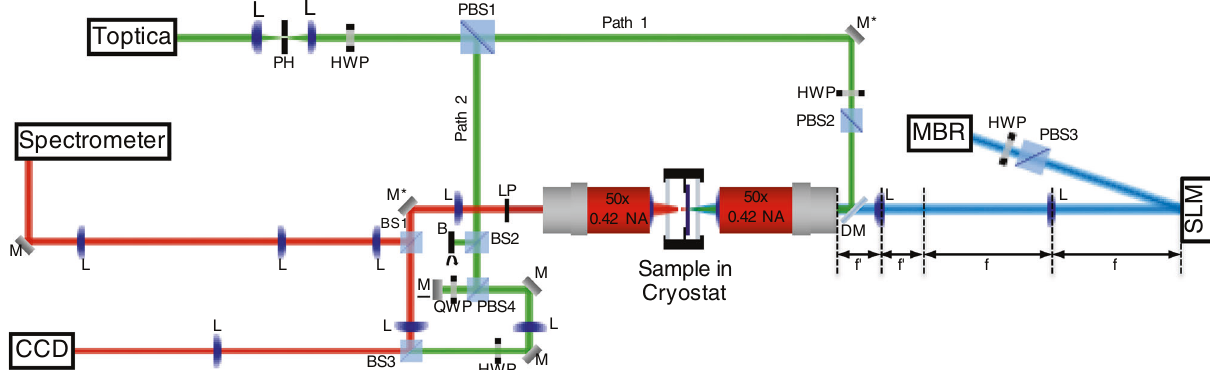
Fig. 6 Experimental set-up. Equipment: mirrors (M, M* (periscope), M (mounted on translation stage), DM (dichroic mirror)); lenses (L); polarising beam splitter (PBS); non-polarising beam splitter (NPBS); half-wave plate (HWP); quarter-wave plate (QWP); long-pass fi lter (LP); and beam block (B). Simultaneously, real-space PL is detected onto the uncoupled CCD and 2D Fourier space is projected onto the spectrometer allowing us to view either the 2D Fourier space or the energy-resolved dispersion by using the grating. The external seed laser is brought to be resonant with the PL by going on the grating and detecting the PL from BS1 and the laser by removing block (B) in front of BS2 and tuning the external laser. For the homodyne interferometry, the external seed laser is split before the sample, along path 1, a small amount seeds one of the condensates, while along path 2, the remainder is interfered with the PL on BS3. The path of the external seed laser is shown in green, the PL is shown in red and the excitation laser is shown in down path 1, directed onto the sample using a dichroic mirror, which passes the excitation laser but re fl ects the PL wavelength; and the rest down path 2 where the laser is interfered with the PL on BS3 for homodyne interferometry. The remainder of the excitation laser is fi ltered with a long pass fi lter and the paths are brought to zero time delay by controlling mirror M, which is on a linear translational stage. 2D Fourier- and real-space PL imaging are obtained by projecting the corresponding space onto a cooled charge-coupled device (CCD) camera. Initially, we viewed the system by time averaging over multiple instances of the condensate to obtain real- and Fourier-space images. The PL is then directed at a second SLM (not shown) where the hologram design allowed us to investigate the fi rst-order mutual coherence function between any two condensates from the polygon 76 . The selected PL was projected onto a CCD in Fourier space so that the mutual coherence between the two condensates under investigation could be seen in the resultant interferogram. The magnitude of the ∣ g (1) ∣ is extracted from the interferograms by fi tting with where I int , I 1 , and I 2 are read from line pro fi les along a direction x taken across the images of the interference, reference arm 1, and reference arm 2, respectively 77 . The fi tting parameters are the phase ( θ ), wavenumber ( k ), and coherence magnitude ( ∣ g (1) ∣ ), allowing us to directly extract the phase and coherence for each data set.